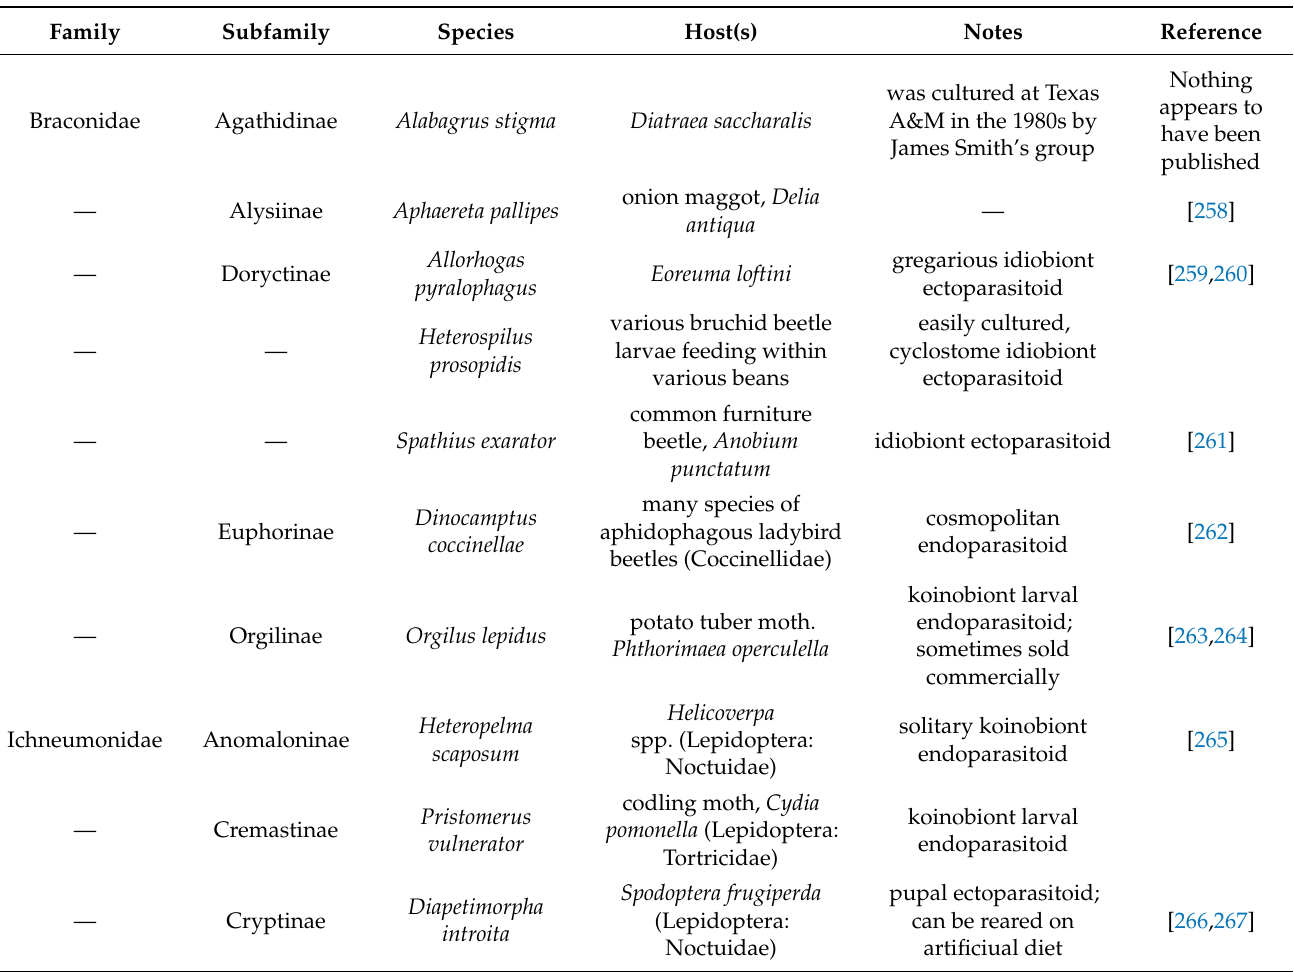
Table 11. Selected non-PDV carrying ichneumonoid wasp species not yet investigated but which ought to be amenable to culture and laboratory investigation.